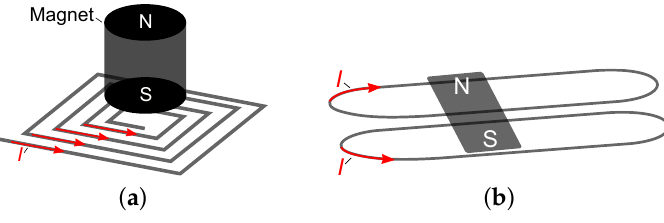
Figure 3. Magnetic levitation micro-actuators ( I is the electric direct current (DC)): ( a ) square coil design for micro-assembly [42]; ( b ) set of coils for a linear actuator